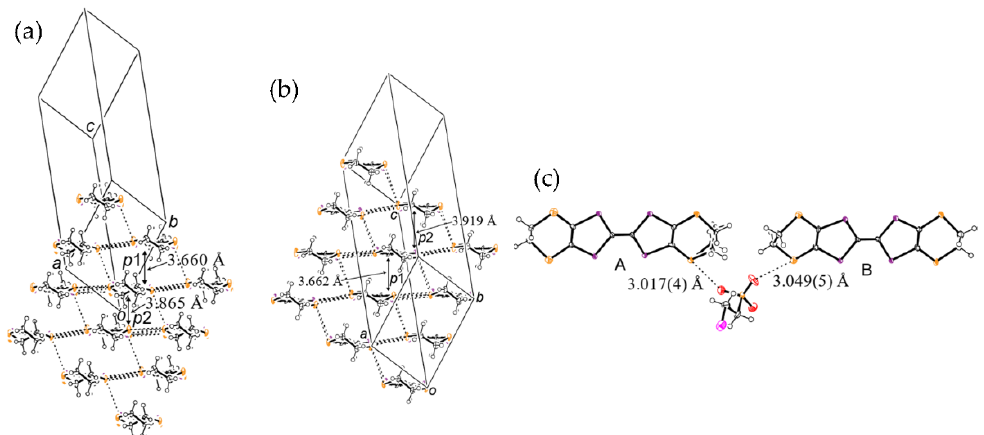
Figure 2. Donor arrangements of ( a ) A and ( b ) B layers of 2 with two crystallographically-independent plane–plane distances, where the dashed lines indicate short Se ··· Se (<3.80 Å), Se ··· S (<3.75 Å), and S ··· S contacts (<3.70 Å). ( c ) Short contacts between donors and anions of 2 .